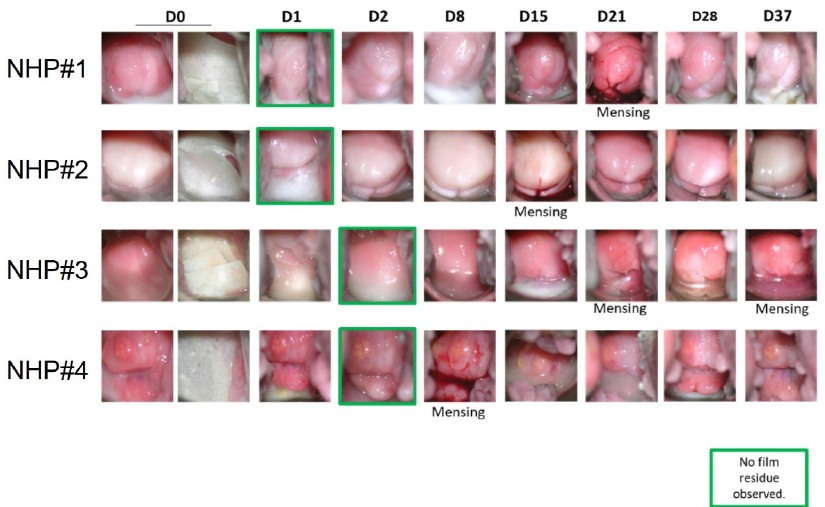
Figure 7. Visual observation of the MK-2048 PNP film in non-human primates (NHP) by colposcopy. Films inserted on Day 0. Green boxes indicate the day when no film residue can be observed. Menses were recorded and shown in the figure. Four non − human primates (NHP) were numbered as #1, #2, #3, and #4.